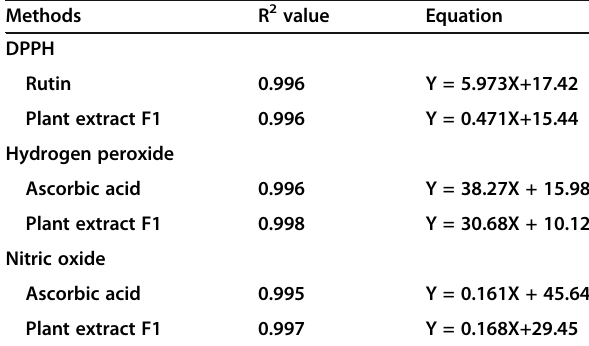
Table 4 Table showing data of R 2 value and linear regression equation of various methods used for the determination of antioxidant activity of plant extract F1